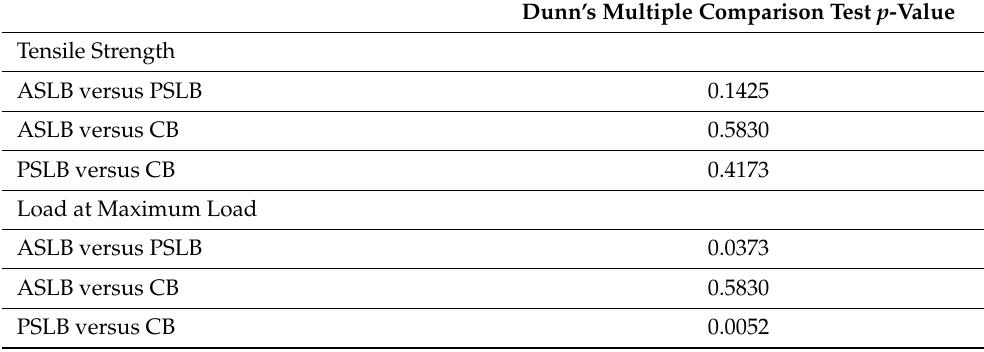
Table 4. Dunn’s Multiple Comparison